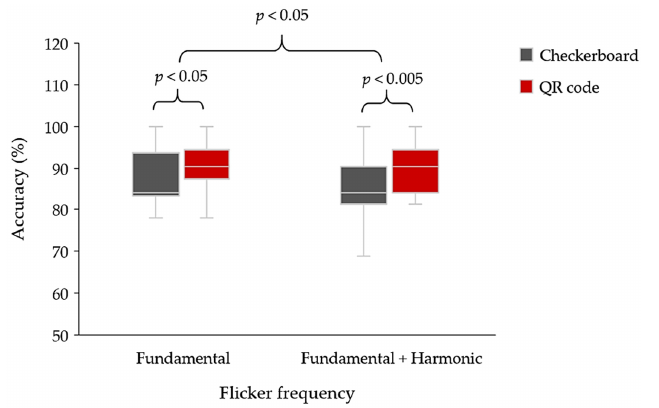
Figure 10. Average classification accuracy between using only the fundamental (flicker pattern 1 and 2) and mixing fundamental and harmonic frequencies (flicker pattern 4 and 5) of the checkerboard and QR code patterns of SSVEP stimulus (shown in Table